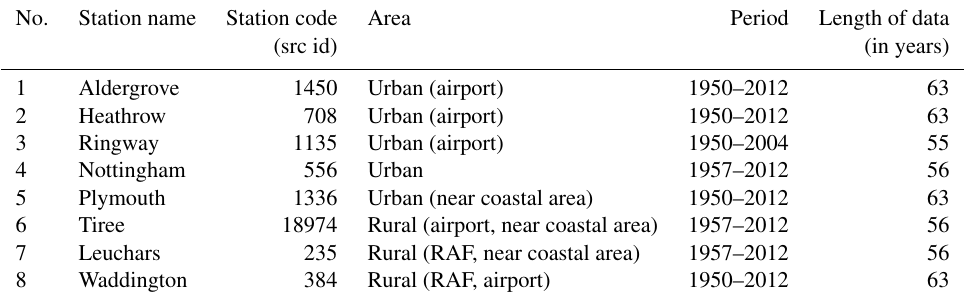
Table 1. Study stations with area and length of data description